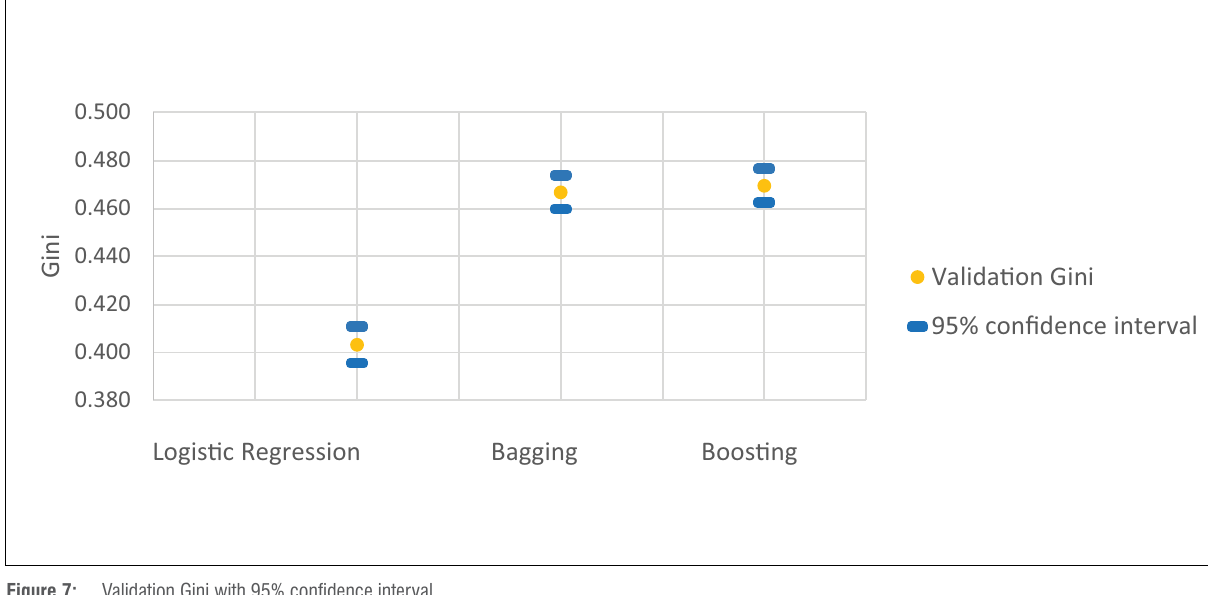
Validation Gini with 95% confidence